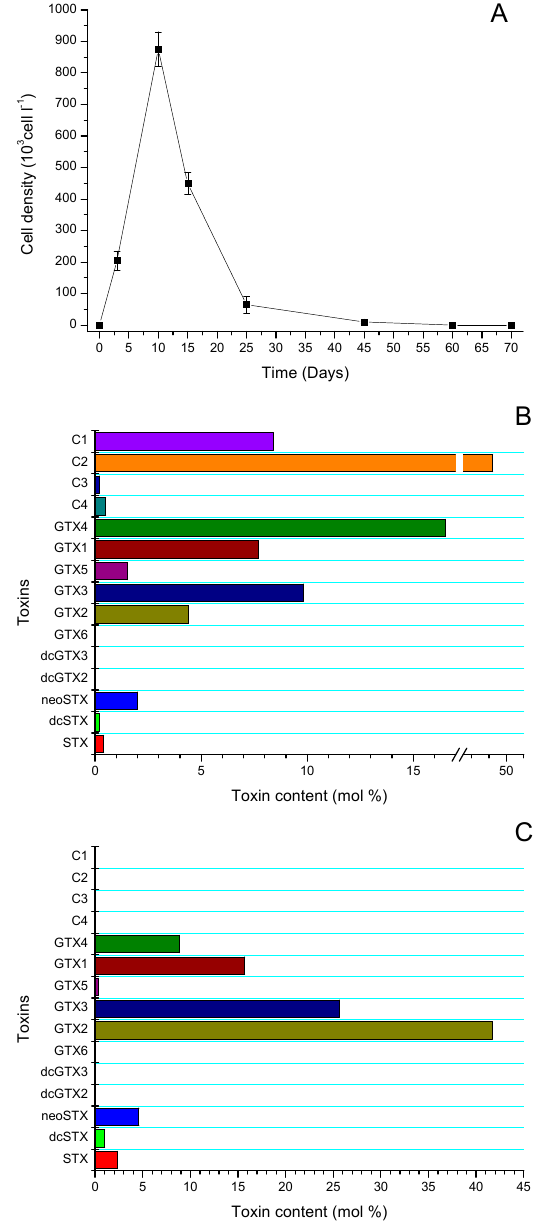
Figure 3. ( A ) Variation in cell concentration (cell/L), and changes in the toxin profile during the ( B ) exponential phase [12], and ( C ) decrease of a bloom of Alexandrium pacificum near Huichas Island, Ays é n Region,